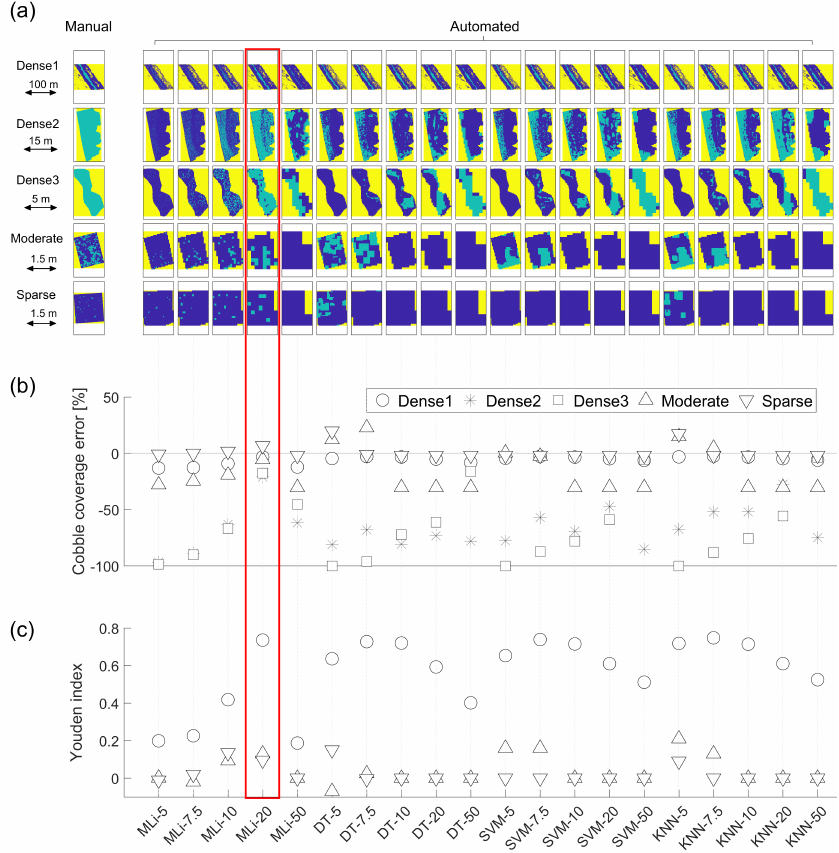
Figure 7. ( a ) Comparison of manual and automated cobble mapping methods at the control sites, and the associated ( b ) cobble coverage mapping errors and ( c ) Youden’s index. Green, blue, and yellow pixels in 7a indicate areas of cobble, non-cobble and no data, respectively. The red box highlights the results of the best performer.